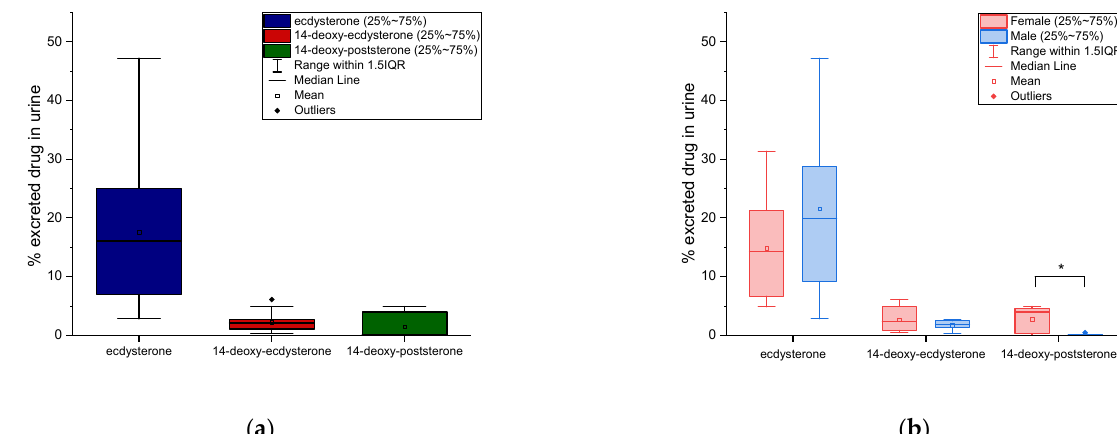
Figure 5. Box-plots of urinary cumulative excretion for ecdysterone, 14-deoxy-ecdysterone, and 14-deoxy-poststerone ( a ) and their comparison in male and female, after administration of 50 mg of ecdysterone ( b ); * significantly different p ≤ 0.05 ( b ).